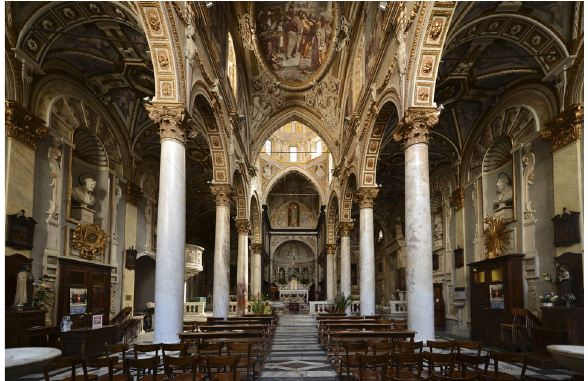
Figure 5. The church during the Reinassance (R. Lavezzaro)